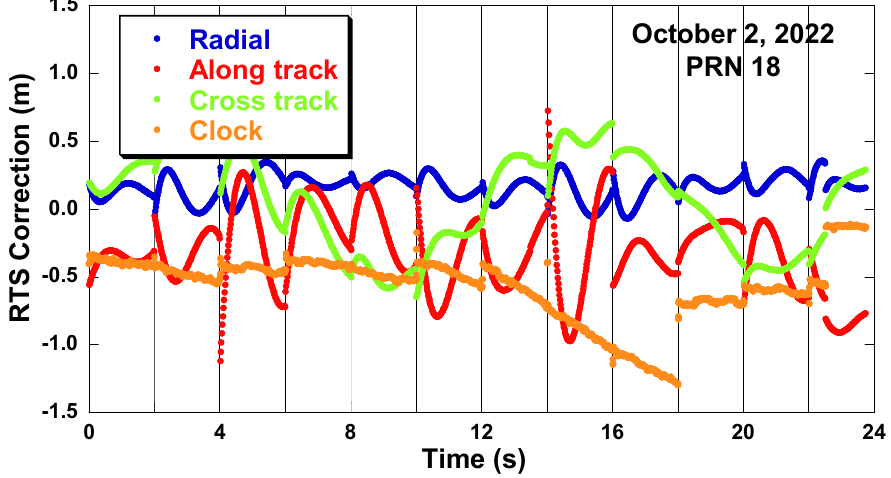
Figure 2. RTS correction discontinuity at IOD changes (GPS PRN18, 2 October 2022).